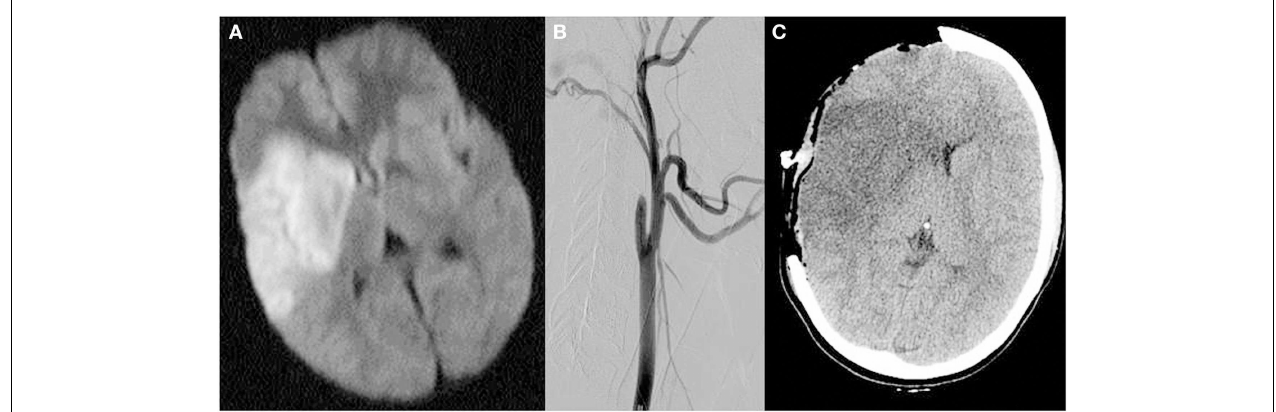
FIGURE 1 | MRI diffusion-weighted images demonstrating restricted diffusion in the right middle cerebral artery territory including the basal ganglia (A), catheter angiogram demonstrating occlusion of the internal